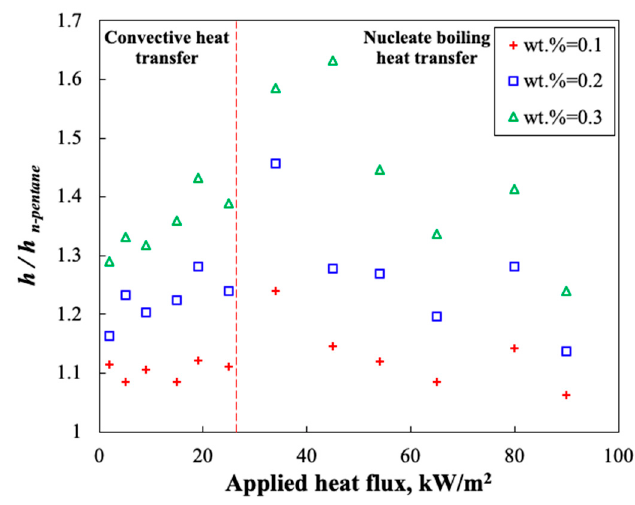
Figure 5. Variation of h nanofluid /h n-pentane with the applied heat flux for various mass fractions of graphene nanoplatelets in n-pentane.